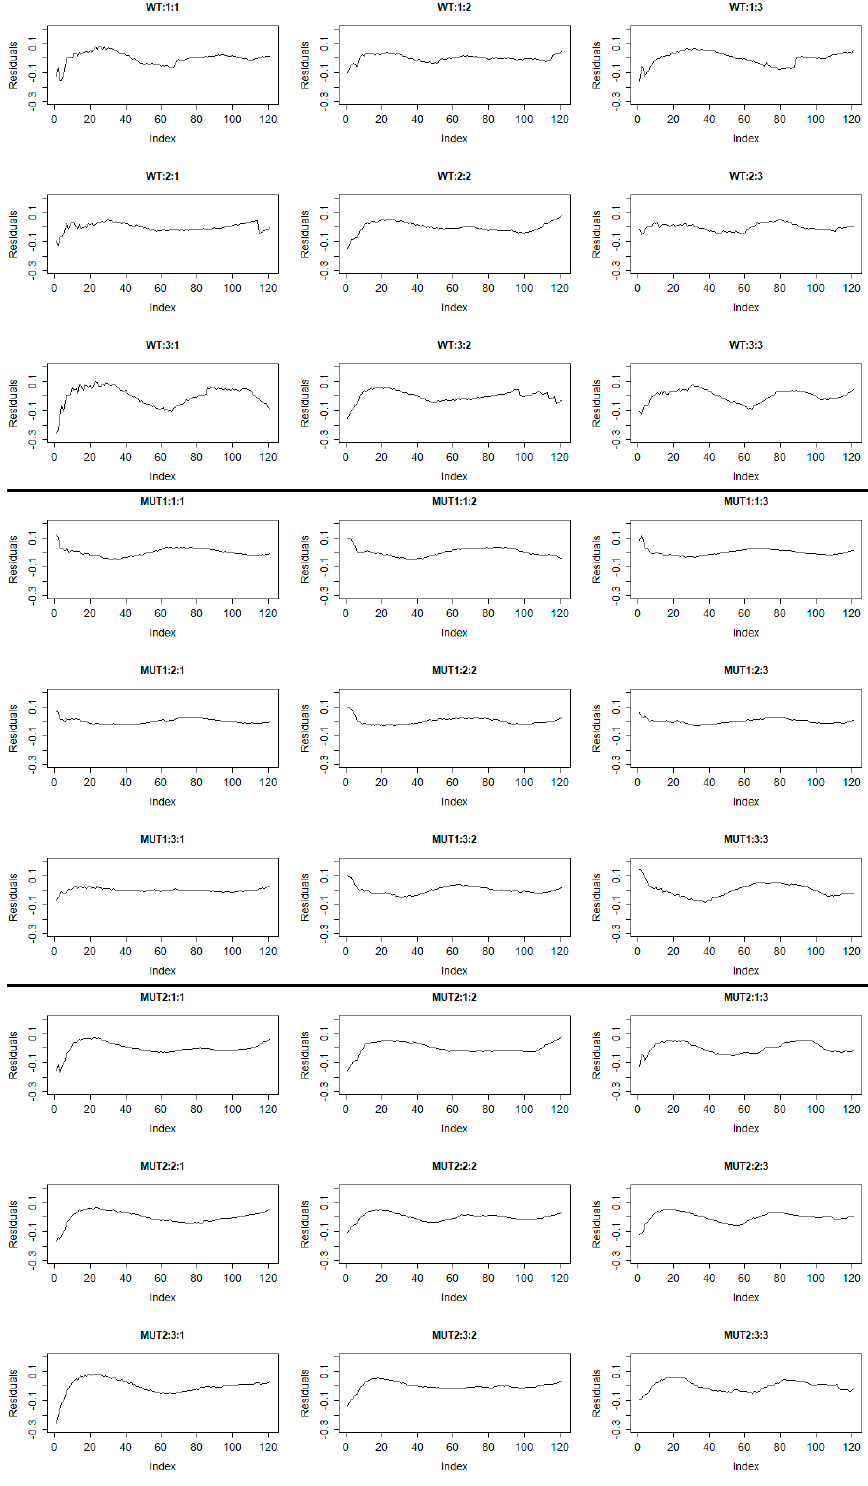
Figure 3. Plot of estimated residuals for each time series of the initial mixed model ( 𝜀 (cid:3036)(cid:3037) in Equation (3)). Index refers to time points (2 min, 4 min, etc.). The title of each plot refers to Genotype: Replicate: Experiment (WT: Wild Type, MUT1: Mutant 1, MUT2: Mutant 2). It is obvious that long-term increases or/and decreases (trend) exist in the residuals of the model given by Equation (3).